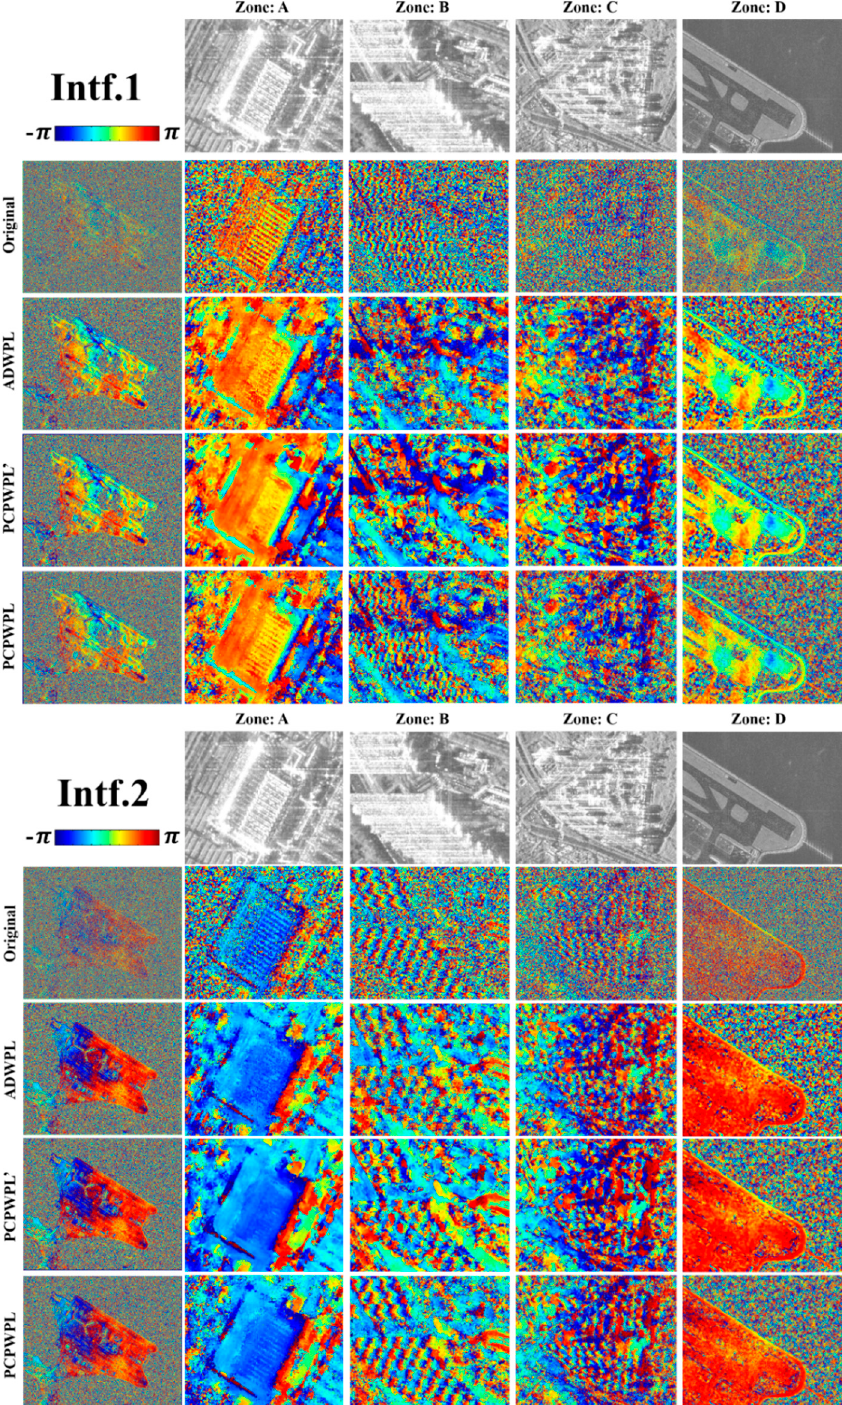
Figure 10. Filtered results of two interferograms by the ADWPL, PCPWPL’, and PCPWPL. Phase details are given using the amplified zones of A-D indicated by red boxes in Figure 9 b, with their corresponding amplitude patterns shown in the first row.